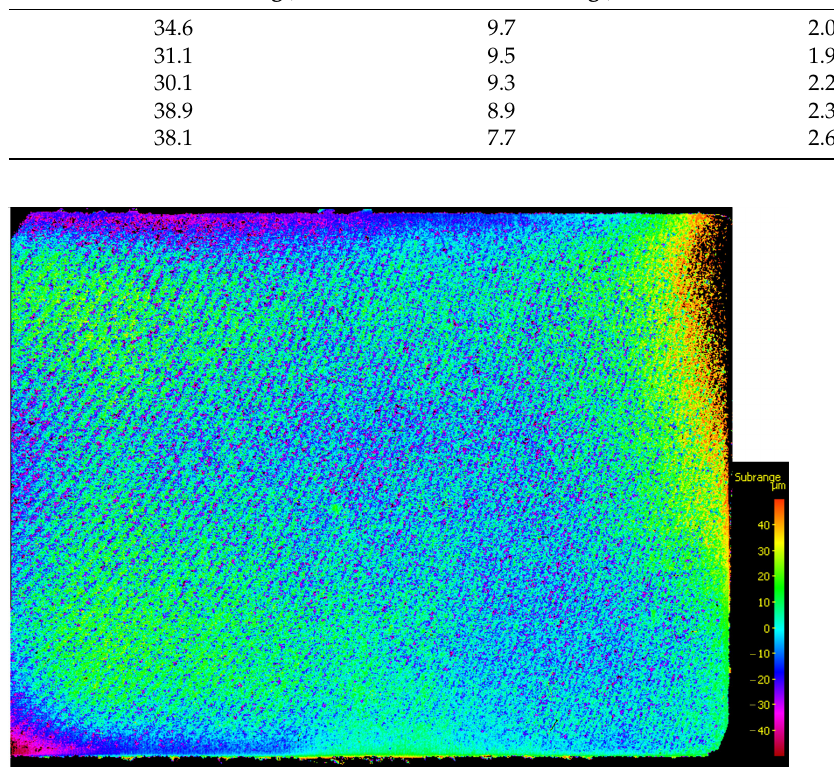
Figure 12. Form removed surface plot of SiC sample using Alicona scan data.